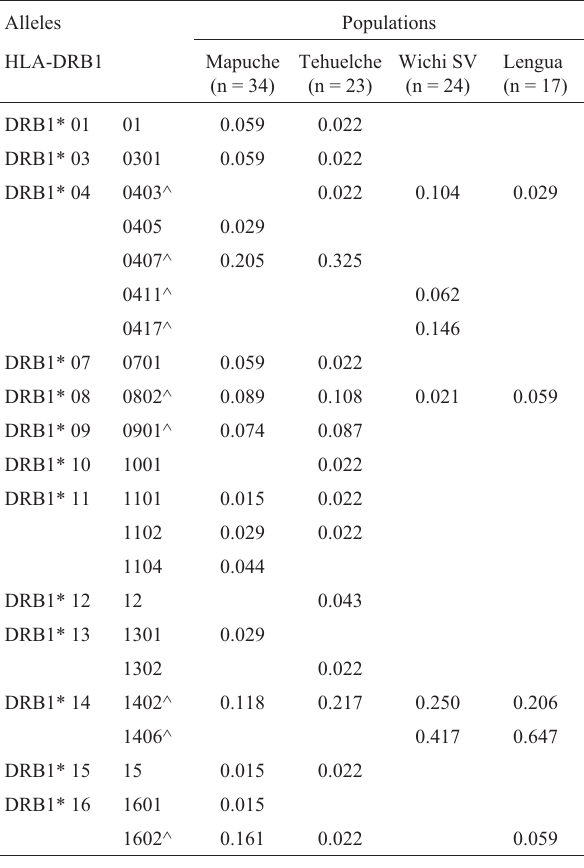
Table 1 - HLA-DRB1 allele frequencies in the four populations studied. Alleles